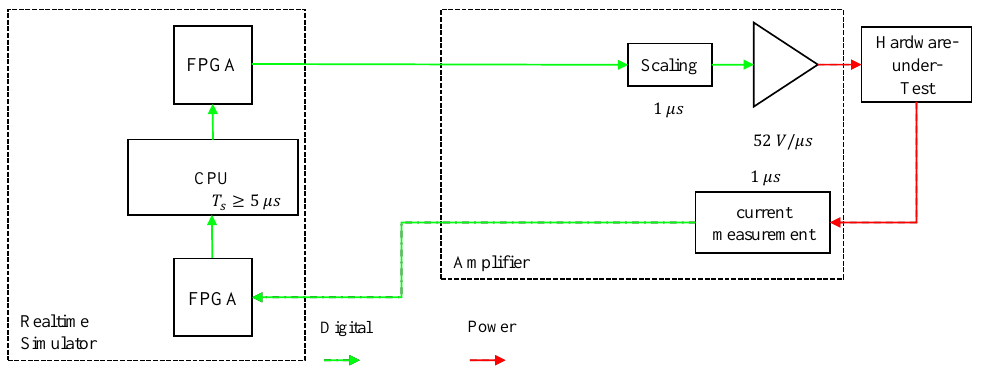
Figure 5. PHiL with digital communication between the RTS and the